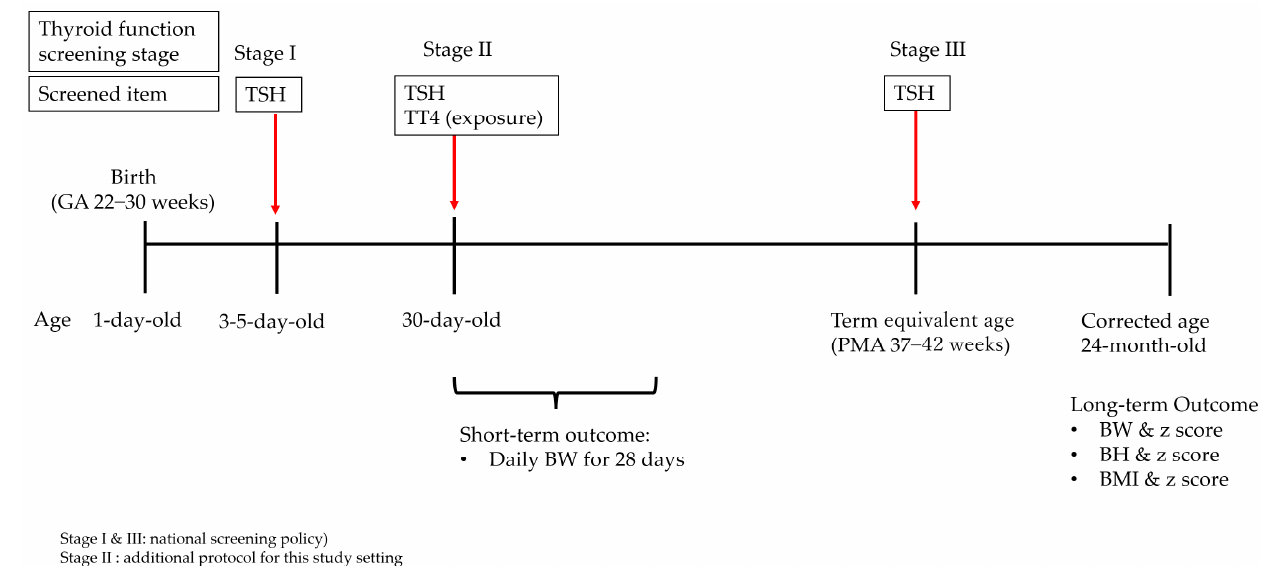
Figure 1. The timing scheme for thyroid function screening (red arrows) and the study design. BW: body weight; BH: body height; BMI: body mass index; GA: gestational age; PMA: postmenstrual age; TT4: total thyroxine; TSH: thyroid-stimulating hormone. Exposure indicates the exposure variable for this study. Stage I: The national screening for TSH concentration. Stage II: The local protocol for assessing the total thyroxine and TSH concentration. Stage III: The national screening is mandatory for preterm infants.